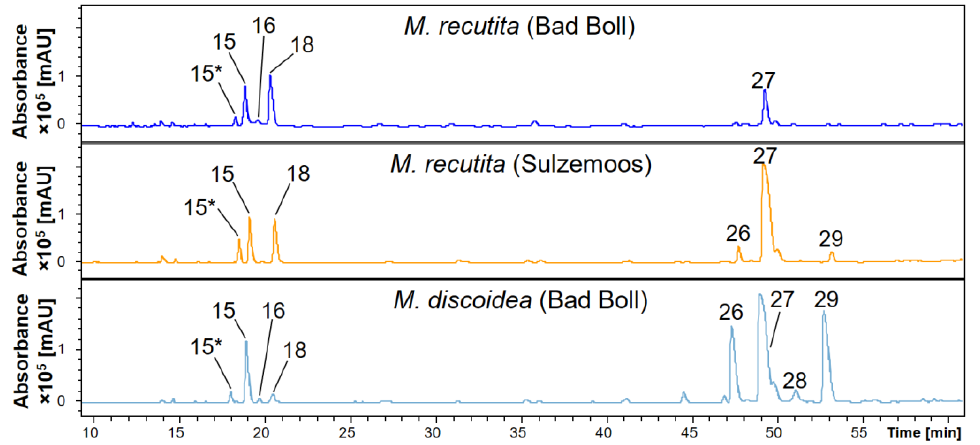
Figure 6. HPLC-DAD UV chromatograms (200–600 nm) showing coumarins and caffeoylquinic acids in n -butanol extracts of different chamomile varieties. Peak numbers refer to Table 2. 15: 5- O - caffeoylquinic acid (* formic acid adduct); 16: fraxin; 18: isofraxidin-7-hexoside; 26–29: 1,4-/1,3-/1,5-/4,5-dicaffeoylquinic acids.